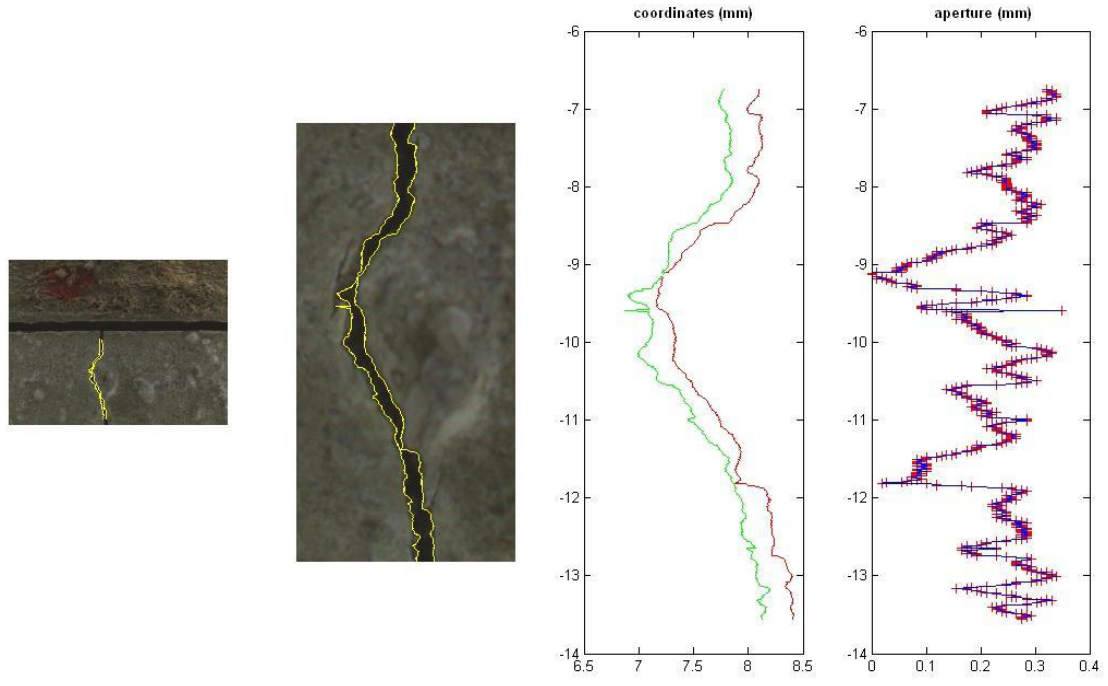
Figure 2. Some results with the implemented software: crack borders and the estimated